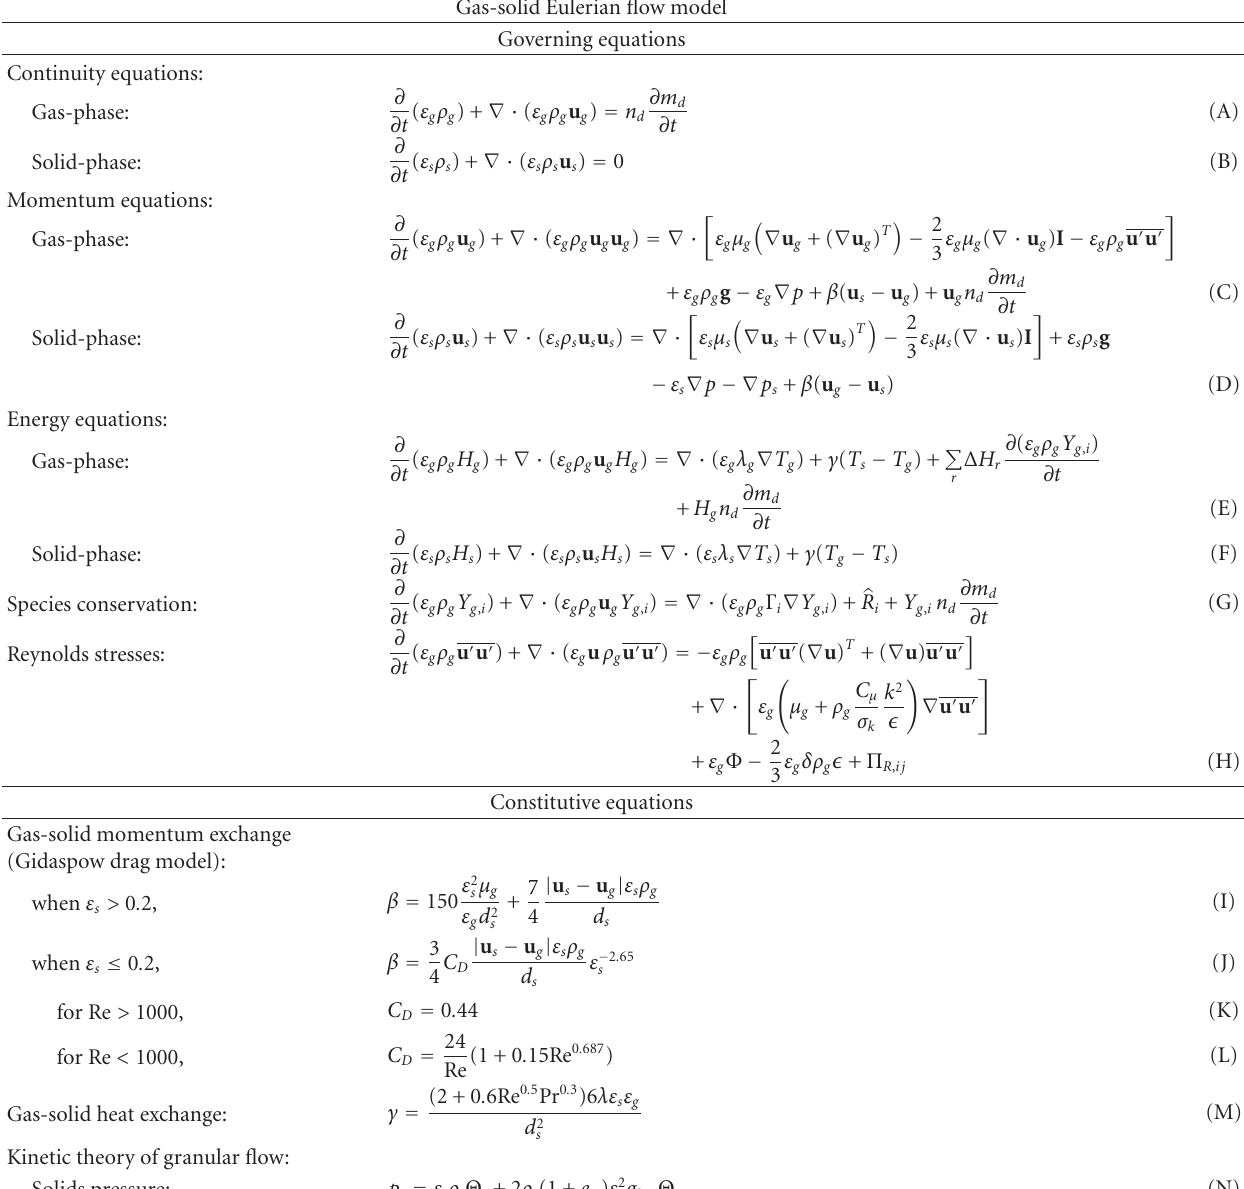
Table 1: Summary of governing and constitutive equations for Eulerian approach. Gas-solid Eulerian flow model Governing